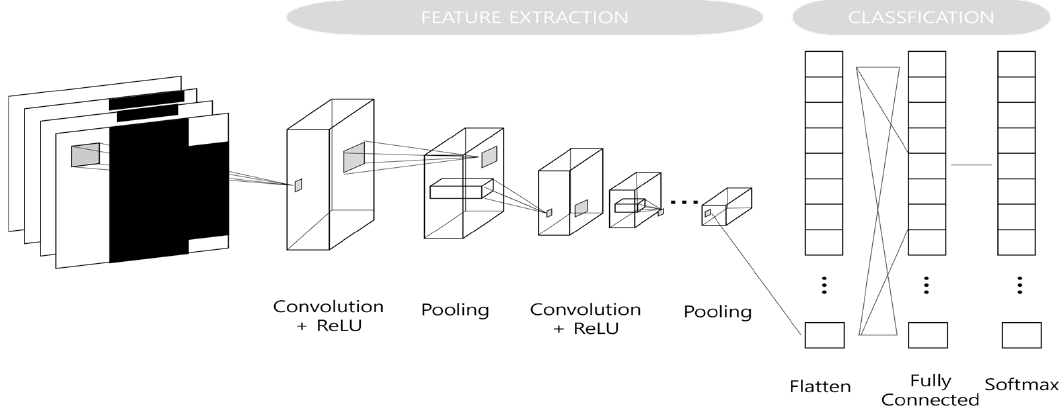
Figure 2. CNN Architecture including feature extraction and classification layer.